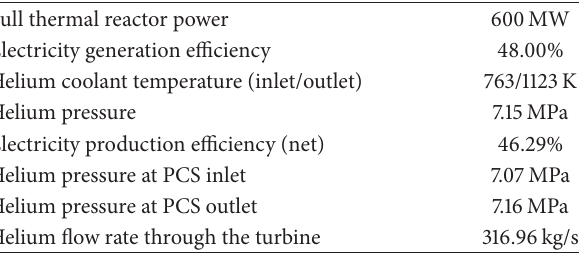
Table 1: Main technical specifications of the GT-MHR